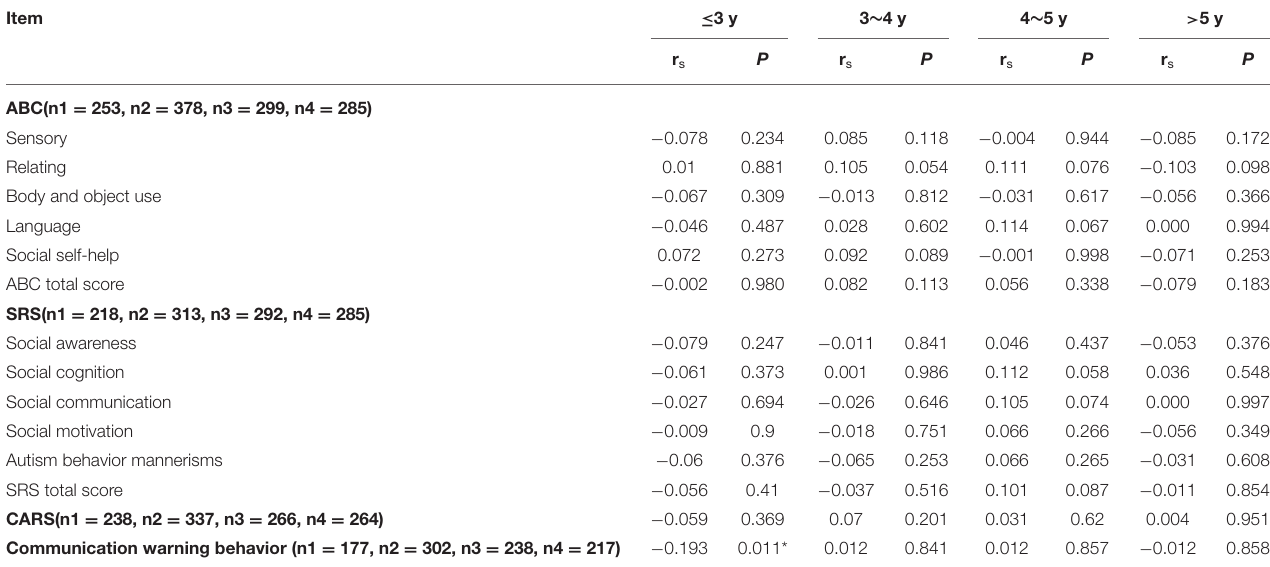
TABLE 3 | Effect of serum folate level on ABC, SRS, CARS, and communication warning behavior score of CNBS-R2016 scores in the ASD children at different age groups. Item